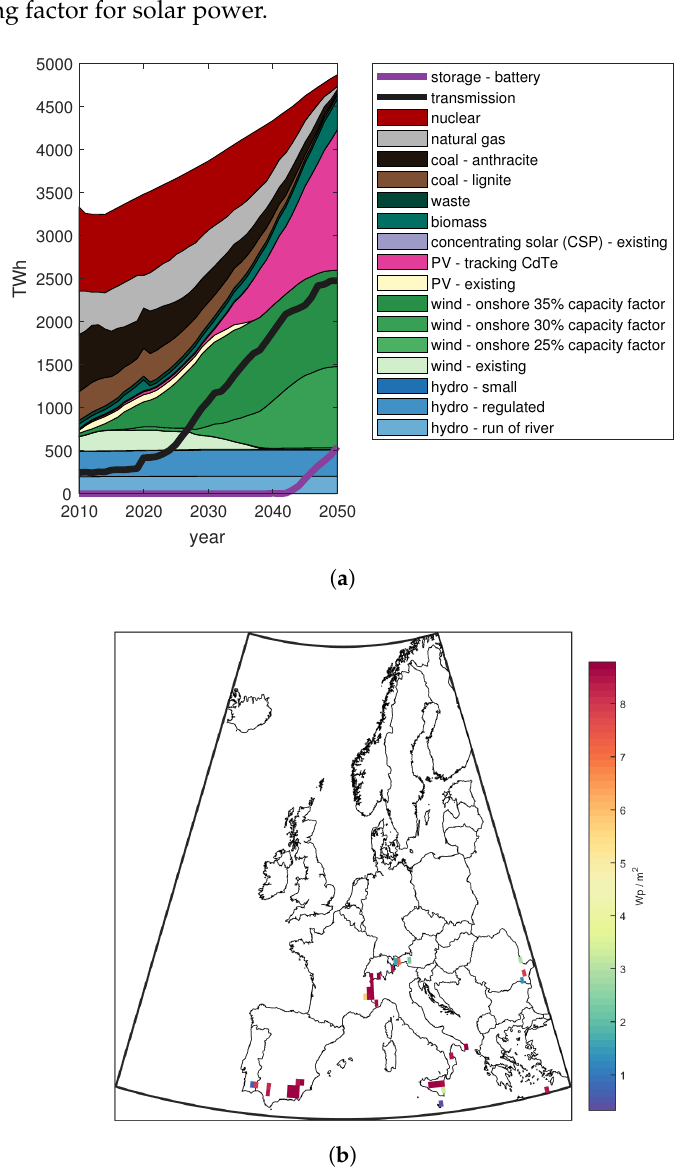
Figure 8. Model results for the lower allowed solar density scenario including ( a ) the electricity generated by generation type and year plus yearly electricity transmitted internationally and yearly energy transferred to storage, and ( b ) the installed capacity of solar PV. Note that the order of the legends for line and area plots corresponds to the order of the respective values in 2010 from top to bottom. Note also that the color of the regions/quadrants on map plots indicates the installed capacity density in the given region/quadrant where white signifies zero